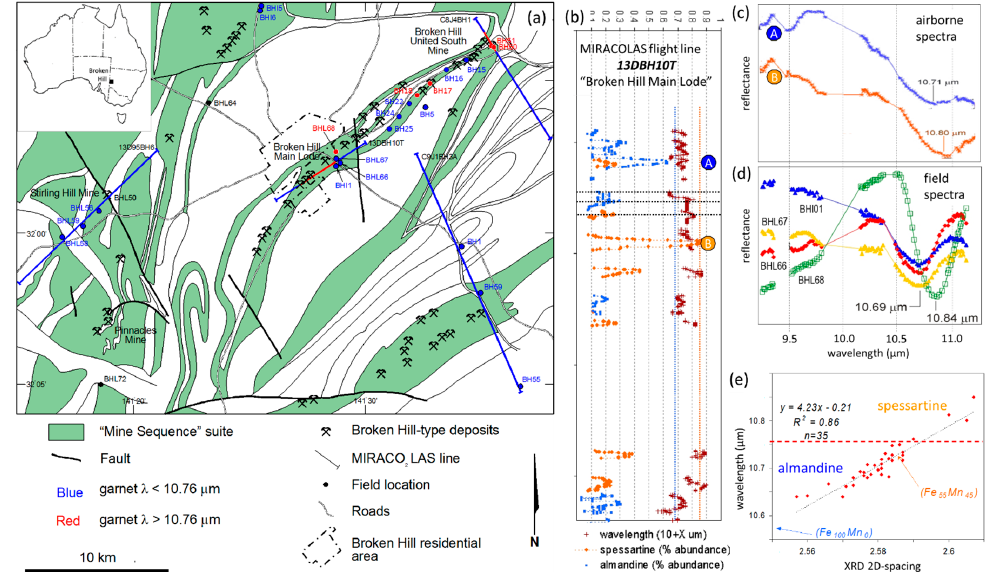
Figure 3. Airborne MIRACO 2 LAS results (~1992) for the Broken Hill area, New South Wales, Australia. ( a ) Map of the distribution of Broken Hill style base metal deposits and their Mine Sequence Suite host rocks (green) [57], together with field sample locations and the tracks of airborne MIRACO 2 LAS surveys which have both been color-coded with respect to garnet TIR reflectance trough wavelength. Scene center is approximately − 31.9669° latitude 141.44134° longitude; ( b ) Segment of MIRACO 2 LAS flight-line “13DBH10T” from over the Broken Hill Main lode open pit and surrounding areas and processed to show the “unmixed” proportion of almandine (blue) and spessartine (orange) garnets as well as the wavelength position of the garnet reflectance trough at approximately ~10,700 nm (10.7 µ m; brown); ( c ) MIRACO 2 LAS pixel spectra of almandine-rich (A; reflectance trough at 10,700 nm (10.71 µ m)) and spessartine-rich (B; emissivity peak at 10,800 nm (10.80 µ m) areas shown in ( b )); ( d ) Laboratory CO 2 laser spectra of garnet-bearing field surface samples—field localities shown in ( a ); ( e ) Scatter-gram of the positions of the laboratory X-ray Diffraction d-spacing peak at 2.58 Angstrom units (10 − 8 cm) (garnet 420 hkl peak) and laboratory CO 2 laser reflectance trough at 10,700 nm (10.7 µ